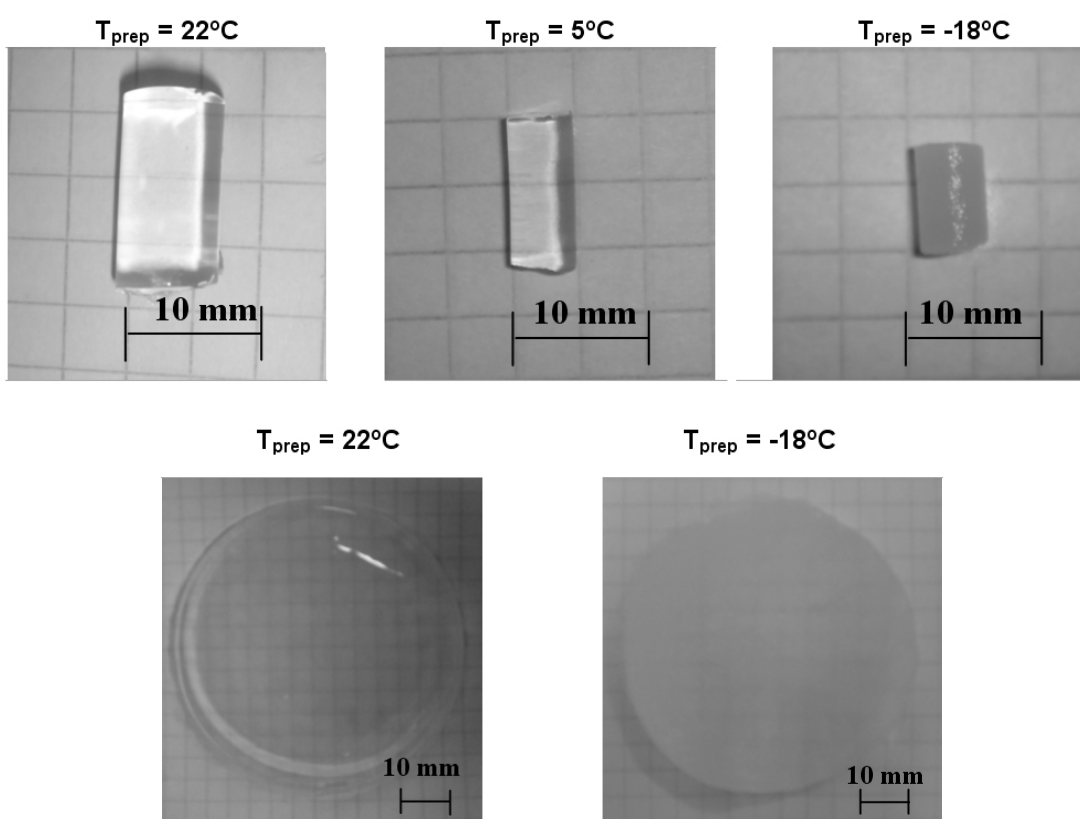
Figure 1. Pictures of PAAm/Dx semi-IPN hydrogels in swollen state prepared in the shape of rods (A) and disks